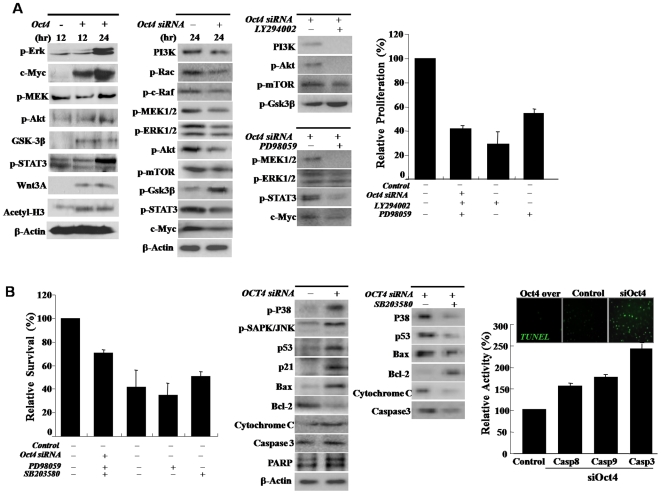
Differentially expressed mRNA and miRNA profiles in Oct4/ATSCs.(A) Global gene expression patterns were compared between control ATSCs and Oct4/ATSCs with DNA microarray. Blue lines indicated that twofold changes in gene expression levels between the paired cell types. Verification of differentially expressed genes in Oct4/ATSC cells (lower panel). (B) The heat map of the different expressed genes between control (Con) and Oct4/ATSCs (O). Positions of several genes including Sox2, FOXD1, and Oct4 and miRNA in scatter plots are indicated. Correlation Coefficiency value of the expression of miRNA in Oct4/ATSCs and control ATSCs was about 0.91. Several miRNA including mir132, mir170, and let7 were highly upregulated after Oct4 overexpression in ATSCs. In contrast of that, mir17 and mir120 was dramatically downregulated in Oct4/ATSCs. The gene expression levels were normalized using the RMA algorithm.